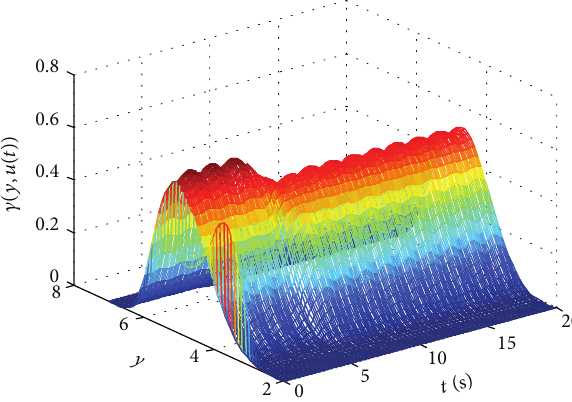
Figure4:TheoutputPDFofthewholeprocesswithoutfaulttolerant control.